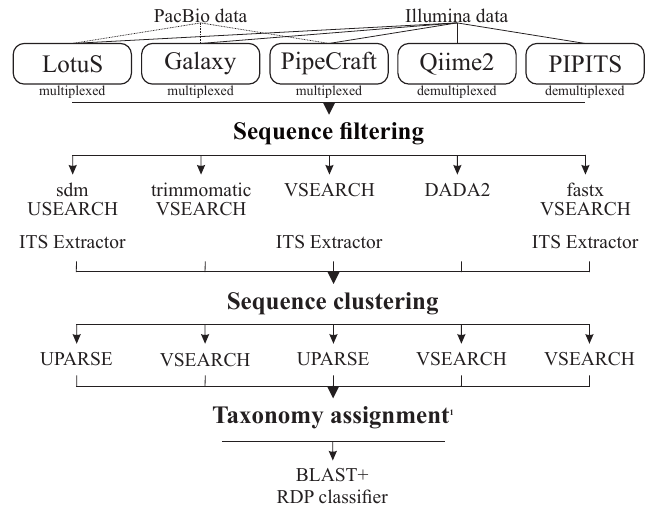
Figure 1. Outline of workflow in different analysis